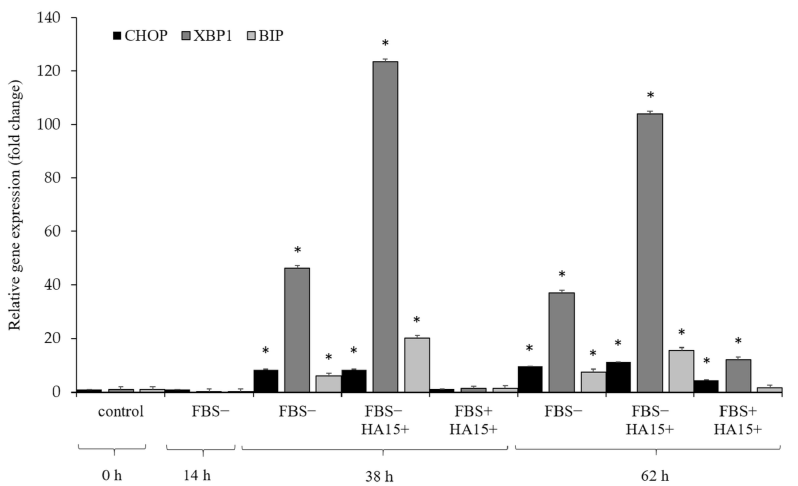
Figure 8. Relative gene expression patterns of stress markers in A375 melanoma cells under dif- ferent culture conditions. Cells were starved for 14 h and then incubated as follows: without FBS (FBS − ), without FBS or with 10 µ M of HA15 (FBS − HA15+), or with FBS and with 10 µ M of HA15 (FBS+HA15+) for 24 h (14 + 24 = 38 h) and 48 h (14 + 48 = 62 h). Significant differences are indicated by asterisks (* p ≤